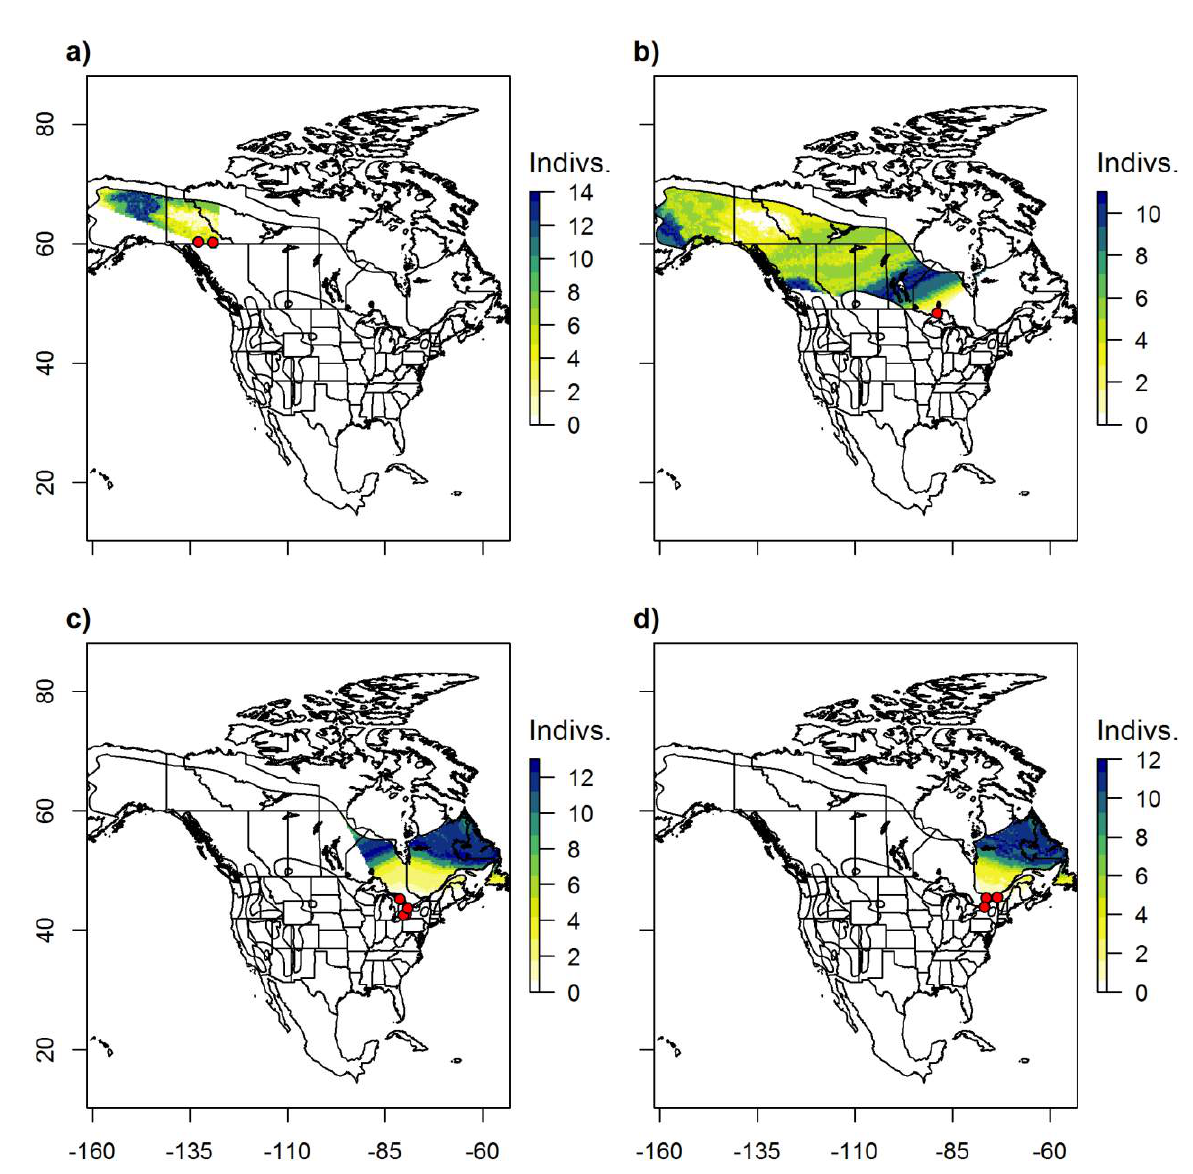
Figure A2.6: Probable origins of Ruby-crowned Kinglets (RCKI; Regulus calendula ) captured during spring migration at CMMN stations in a) the Yukon (ACBO (n=14), TLBBS (n=6)); b) Western Ontario (TCBO (n=17)); c) Southwest Ontario (BPBO (n=5), HBO (n=2), LPBO (n=8), TTPBRS (n=5)); and d) Southeast Ontario & Southwest Québec (IPBO (n=1), MBO (n=3), PEPTBO